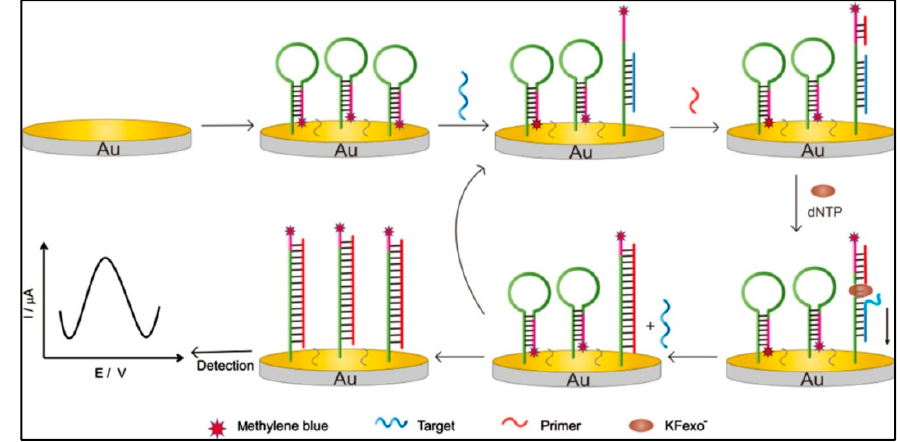
Figure 7. Electrochemical DNA biosensor based on CSRP to detect mecA gene of methicillin-resistant Staphylococcus aureus [147]. Copyright 2015. Reproduced with permission from Elsevier B.V.